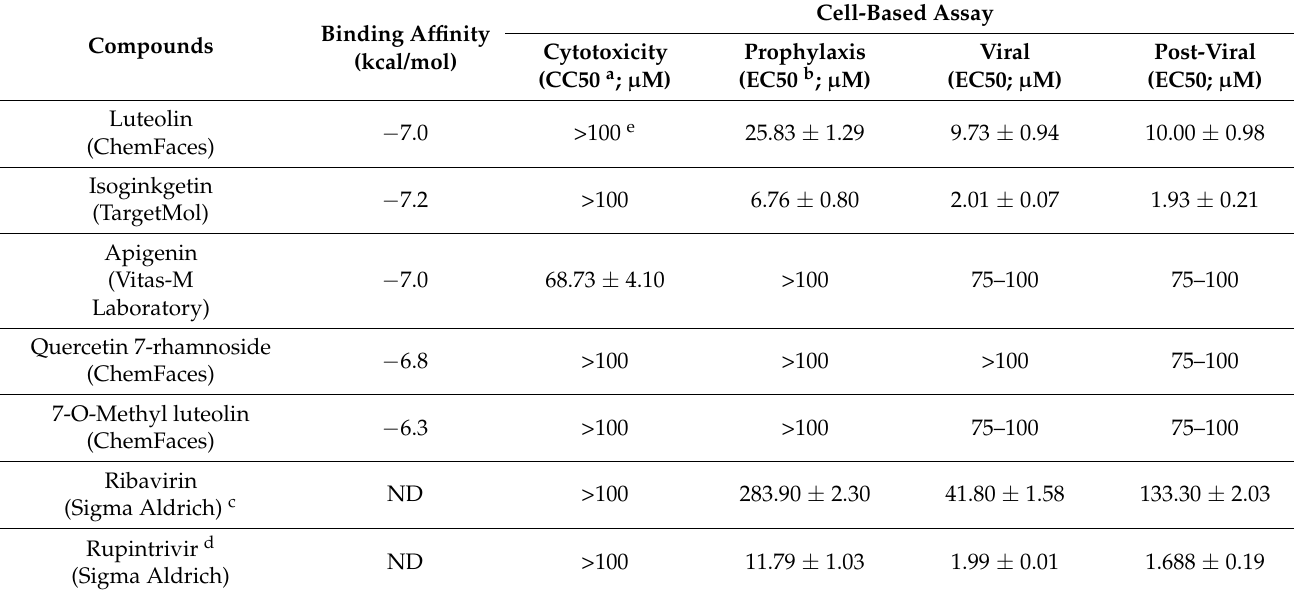
Table 1. Binding affinity to FMDV 3C pro , cytotoxicity to BHK-21 cells, and anti-FMDV activity of phytochemical